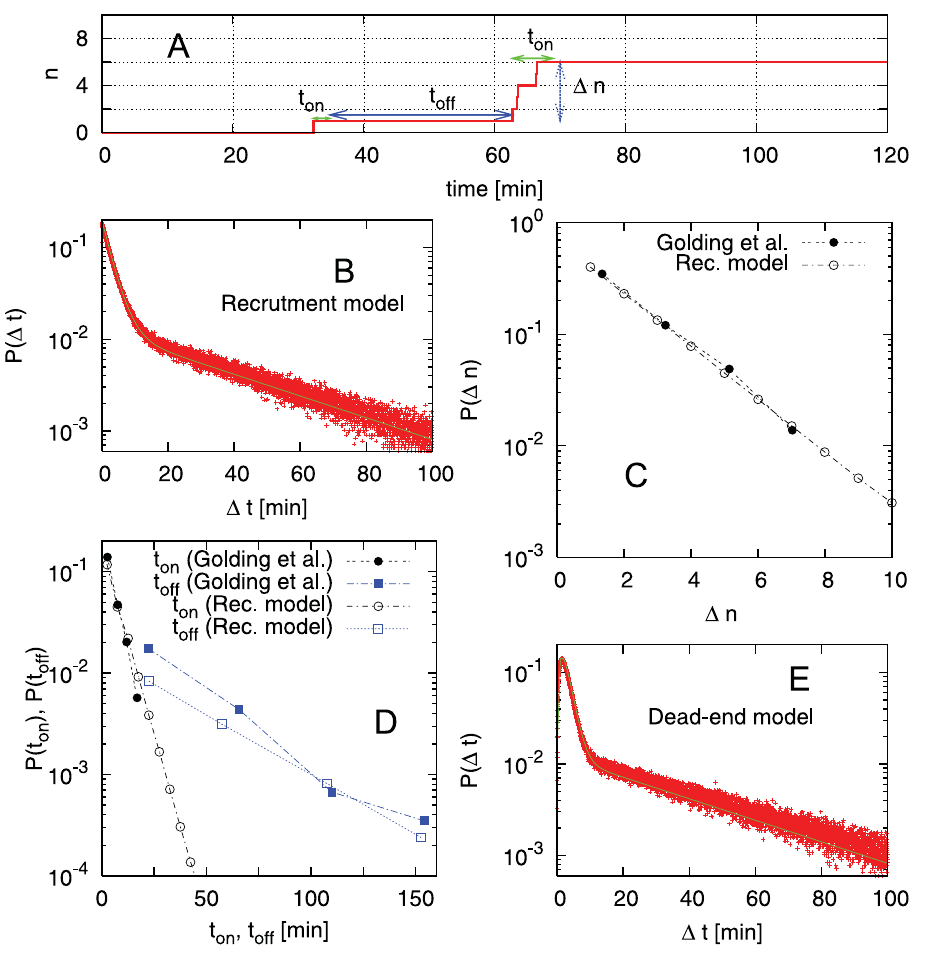
Figure 3. Transcriptional bursting from three step model with supercoiling assisted recruitment and the dead-end complex model. (A–D) show the results from the recruitment model with the probability of recruitment q =0.545. The average firing rate is 1/20 [1/min]. k b = k u =60 [1/min], E =1/2.9 [1/min], O =1/18.3 [1/min], l =35 [bp], v =25 [bp/sec]. (A) Accumulated number of mRNAs, showing on periods and off-periods. Transcriptional bursting can be seen around 62 [min] to 70 [min], where 5 firings occur in rapid succession. See Materials and Methods for the choice of parameters and definitions of t on and t off . (B) The distribution of the durations between firing, P ( D t ). The solid line shows Equation 3. (C) The distribution of the number of firings per on-period, P ( D n ). The filled circles show experimental data from Golding et al [10], and the open circles are D n from the recruitment model. (D) The distribution of the ‘‘on-times’’ t on (open circles) and the ‘‘off-times’’ (open boxes) t off . The experimental data from Golding et al. for the on-time (filled circles) and off-time (filled boxes) are also shown. (E) The distribution of intervals between initiations for the dead-end complex model (Figure 2B). The probability of productive elongation is Q =0.545, and the rate of removal of dead-end complexes is d =1/ t dead =1/(20 [min]). The average firing rate is 1/22 [1/min]. k b = k u =60[1/min], E =1/1.5[1/min], O =1/0.7 [1/min], l =35 [bp], v =25 [bp/sec]. This parameter choice corresponds to a Class 2 promoter in the on periods, which gives a round curve for short timescales (around 3 [min]). The solid line